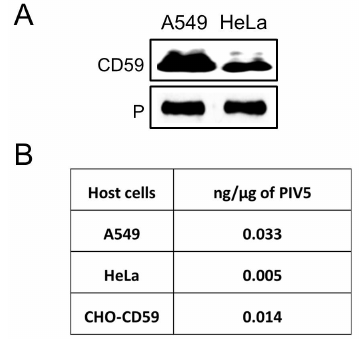
Figure 1. CD59 is associated with PIV5 virions. ( A ) PIV5 derived from the indicated cell lines was purified by gradient ultracentrifugation and analyzed by Western blotting for the presence of CD59. Levels of viral P were analyzed as a loading control. ( B ) PIV5 derived from the indicated cells was analyzed by quantitative Western blotting against known amounts of purified CD59. Relative amounts of CD59 are expressed as ng/ µ g of purified virus. Results are the average of two independent experiments.